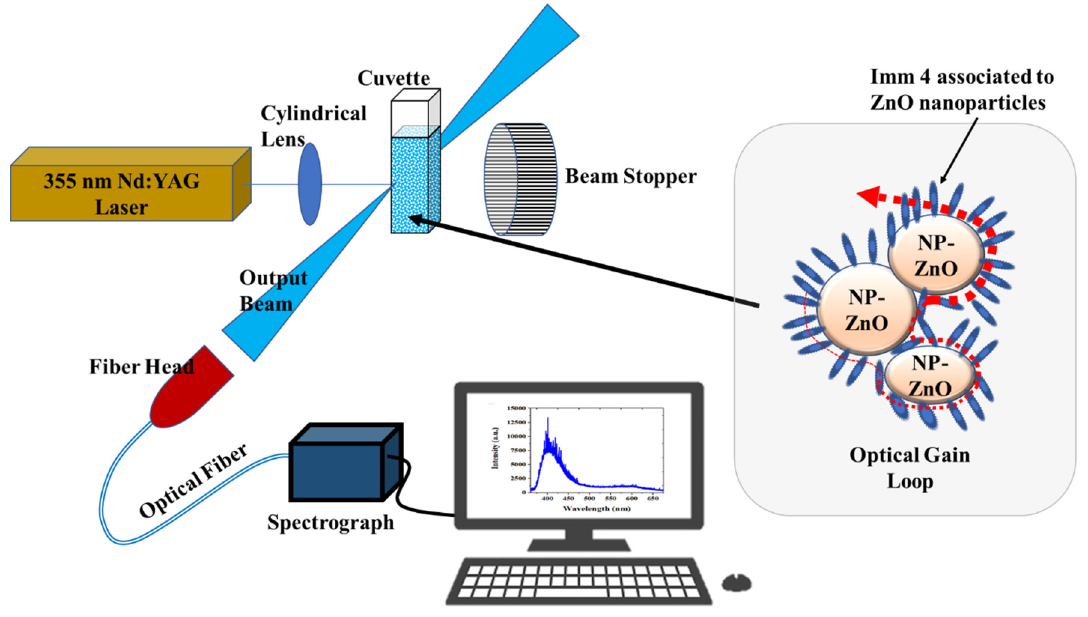
Figure 8. Experimental set-up; (inset) schematic of 5d attached to ZnO nanoparticle and random laser gain loop.